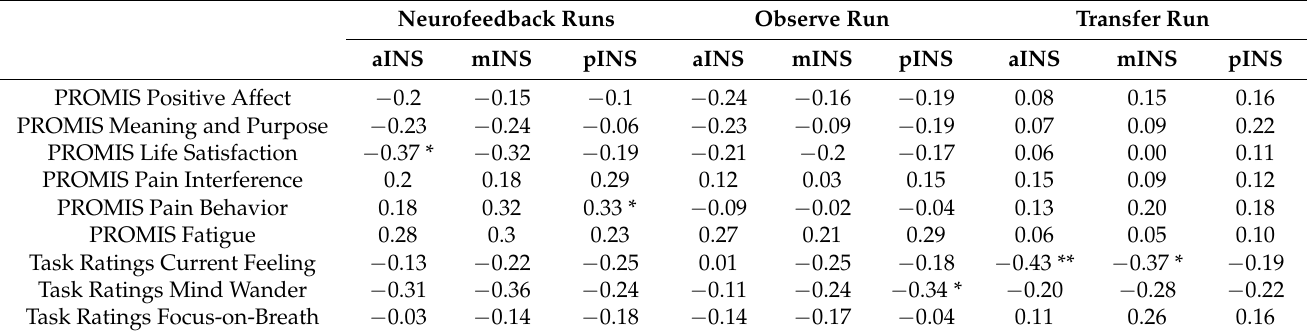
Table A5. Correlations between parameter estimate (Focus-on-Breath vs. Describe) in insula subre- gions during neu-rofeedback runs and variables of interest.